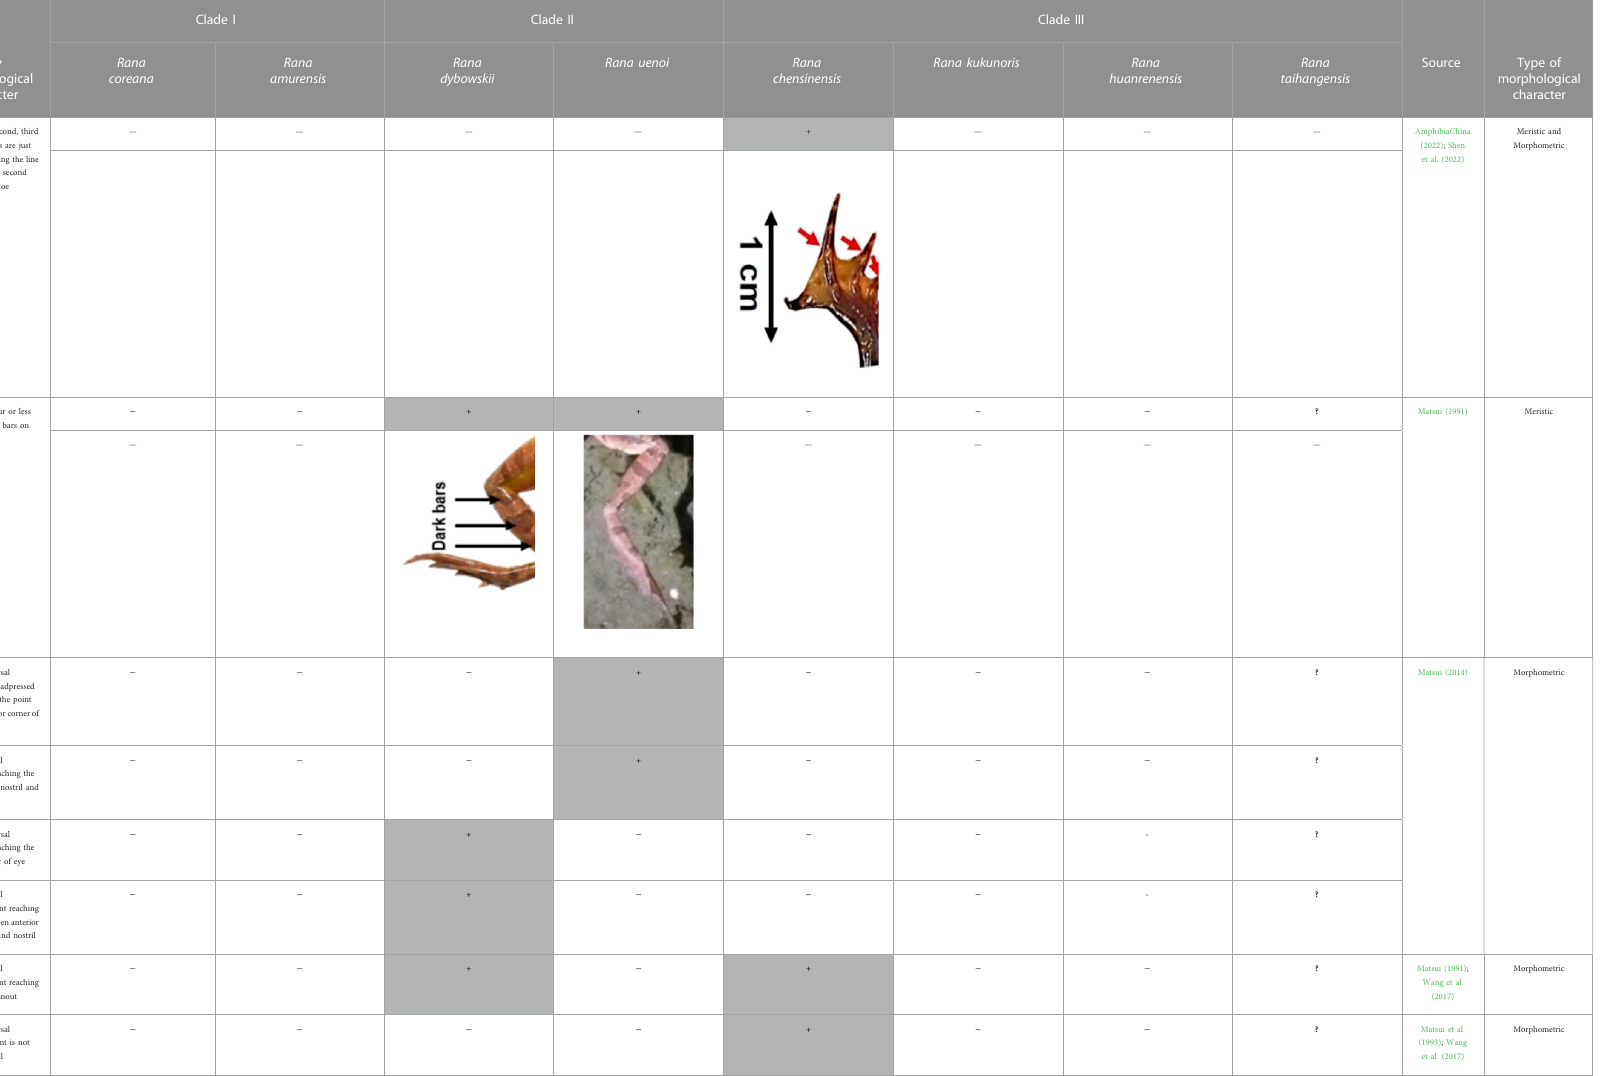
TABLE1( Continued )Identi fi cationkeyandcomparisonof40morphological charactersbetweeneightspeciesofnortheasternAsianbrownfrogs(genus Rana )recordedfromtheliteraturesandonlinedatabasesofamphibians: AmphibiaWeb (https://amphibiaweb.org)andAmphibiaChina (https://www.amphibiachina.org/).Theboxescoloured ingreyandmarkedwithsymbol(+)indicatethepresence ofthecharacterinthespeciesandthecolourless boxes marked with symbol ( − ) indicate the absence of the character in the species, OR, the absence of de fi nitive information but matching with at least a few individuals of the species. The symbol (?) indicate the lack of information about the speci fi c morphological character. Coloration outside of the breeding season is not speci fi ed as the trade is limited to the breeding season when body condition makes frogs more suitable for human consumption. The comparison of morphological characters and classi fi cations of Rana into clades I, II and III in the table are adapted from the operational taxonomic units (OTU) based on the 16S rRNA phylogeny of Othman et al. (2022), where R. chensinensis matches with OTU 7 and R. taihangensis matches with OTU 1 and 2, following Shen et al.